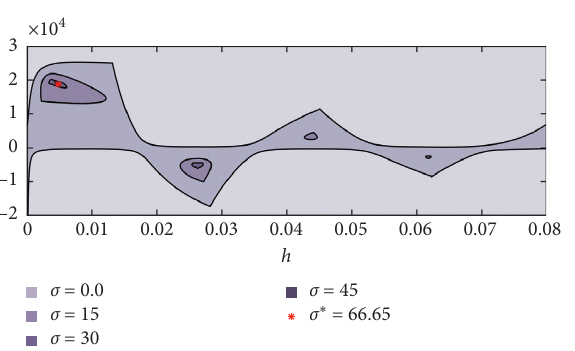
Figure 4: σ -stability boundaries.